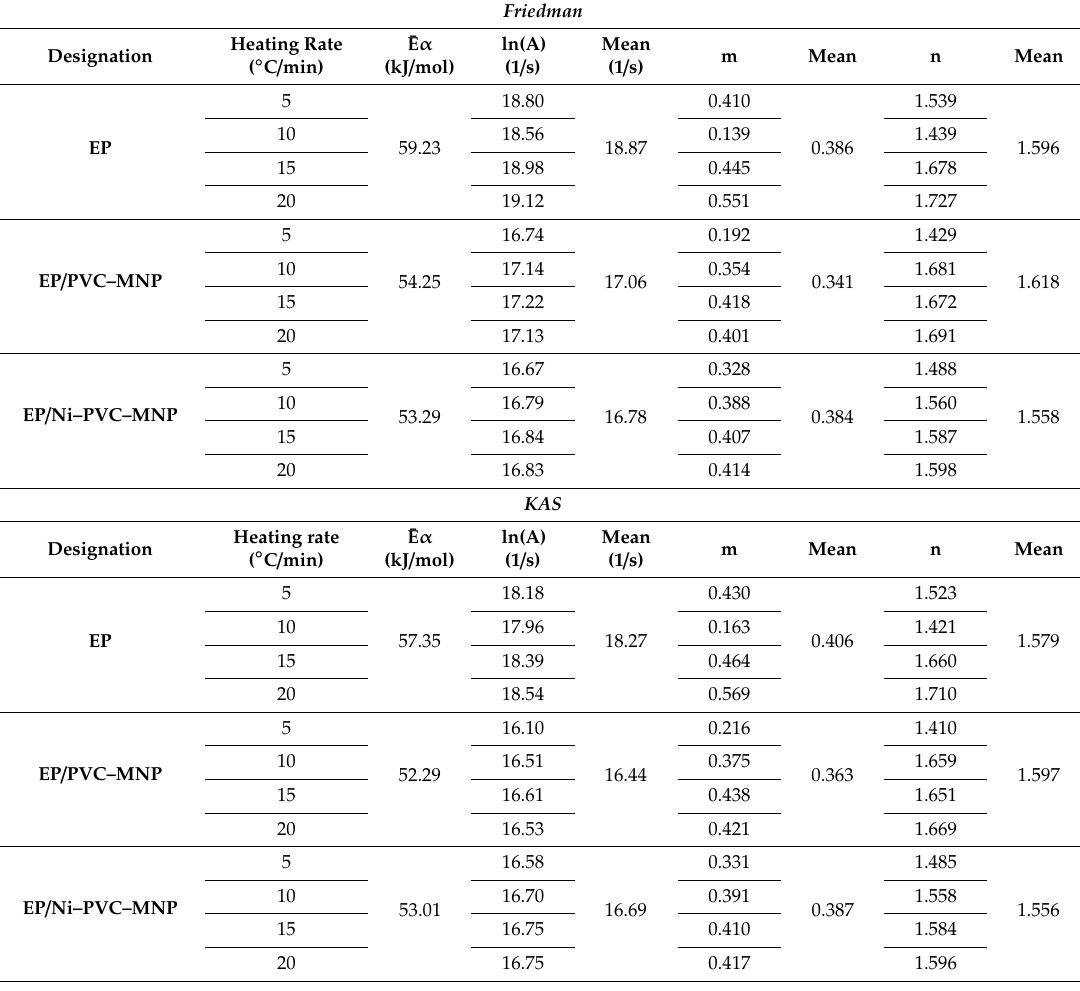
Table 4. Kinetic parameters obtained from Friedman and KAS